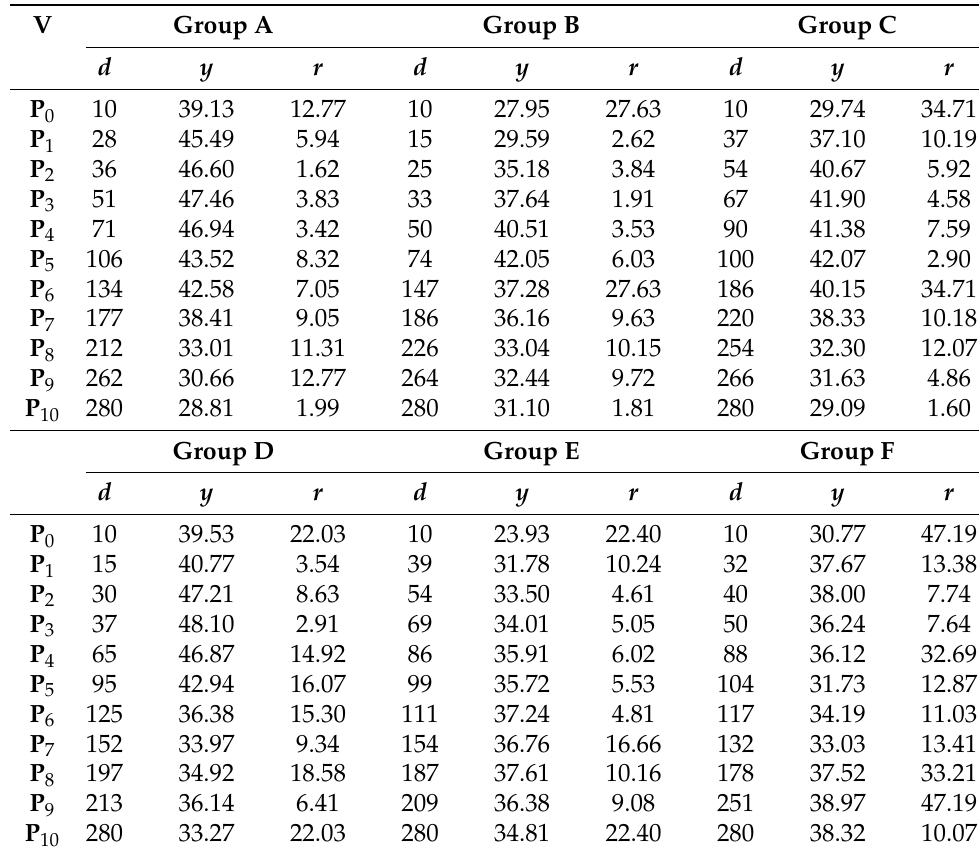
Figure 5. BIC test results of the PWLR model for the LC groups in Table 2. Table 3. LC vectors for the LC groups in Table